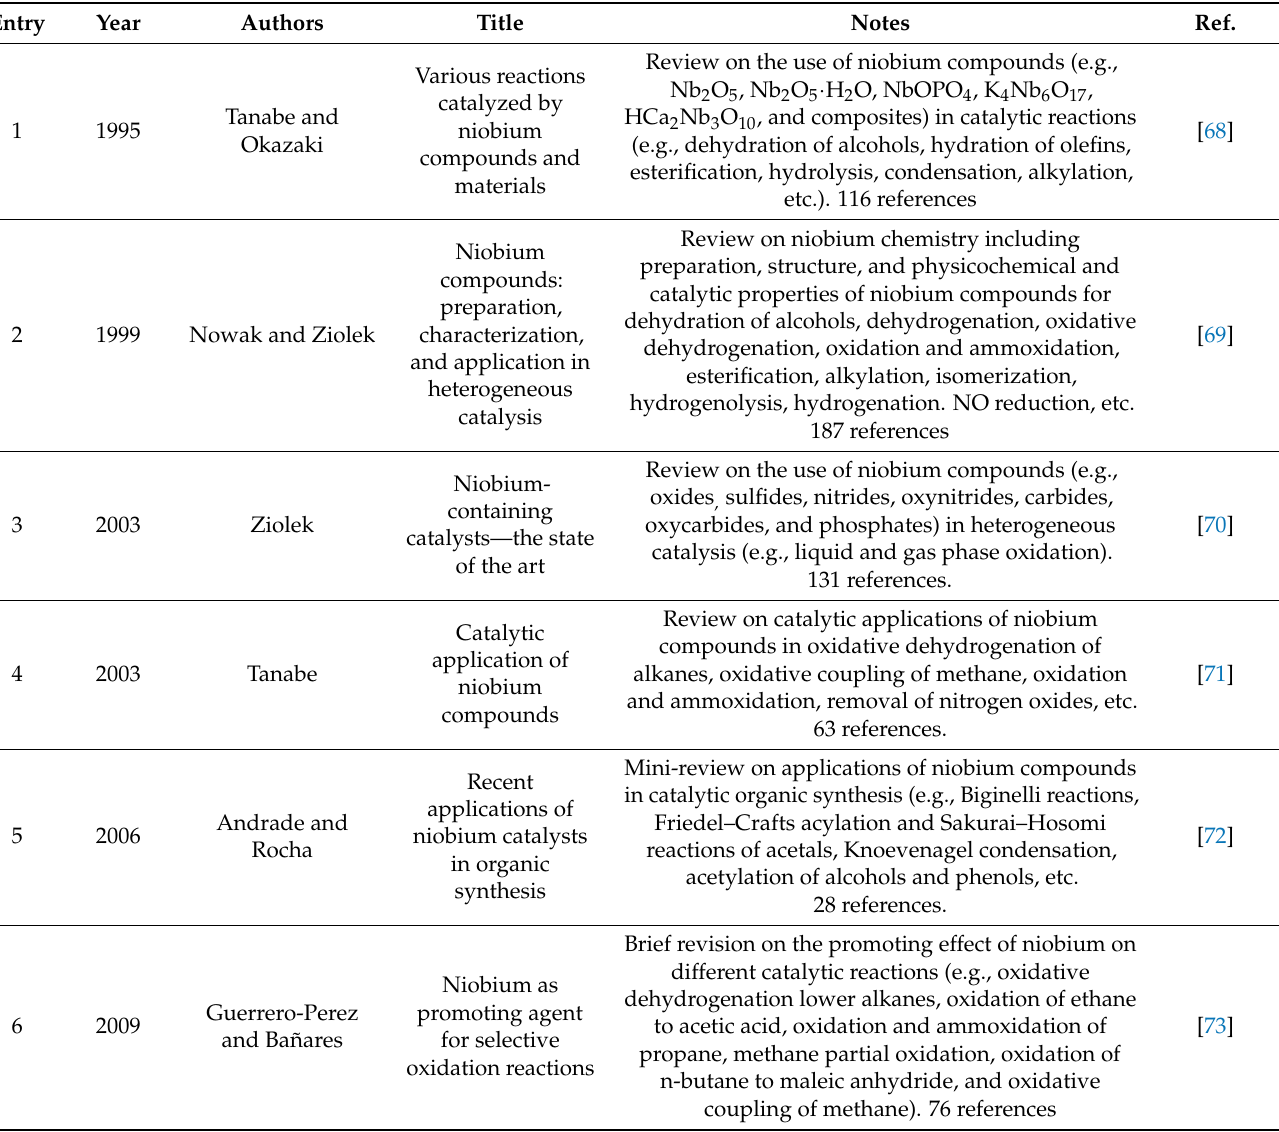
Table 1. Review papers on the synthesis, characterization, and catalytic applications of niobium compounds over the last 30